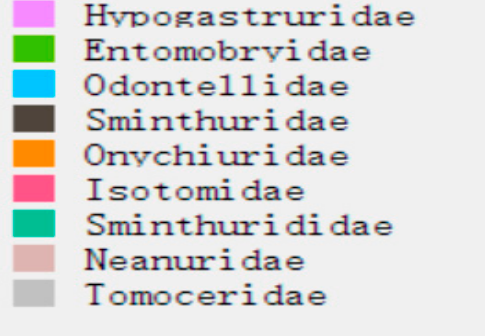
Figure 3. Network of co-occurring Collembola species based on correlation analysis. Communities of six treatments, RT-MC ( a ), RT-CS ( b ), MP-MC ( c ), MP-CS ( d ), NT-MC ( e ), and NT-CS ( f ), included in this experiment to identify the different correlations between species. A strong (Spearman’s r = 0.6) and significant ( p = 0.01) correlation is defined as a connection. The width of every connection connecting two nodes (edge) is proportional to the value of Spearman’s correlation coefficients; the size of every node is proportional to the relative abundance. 9 Collembola families color the co- occurring network.